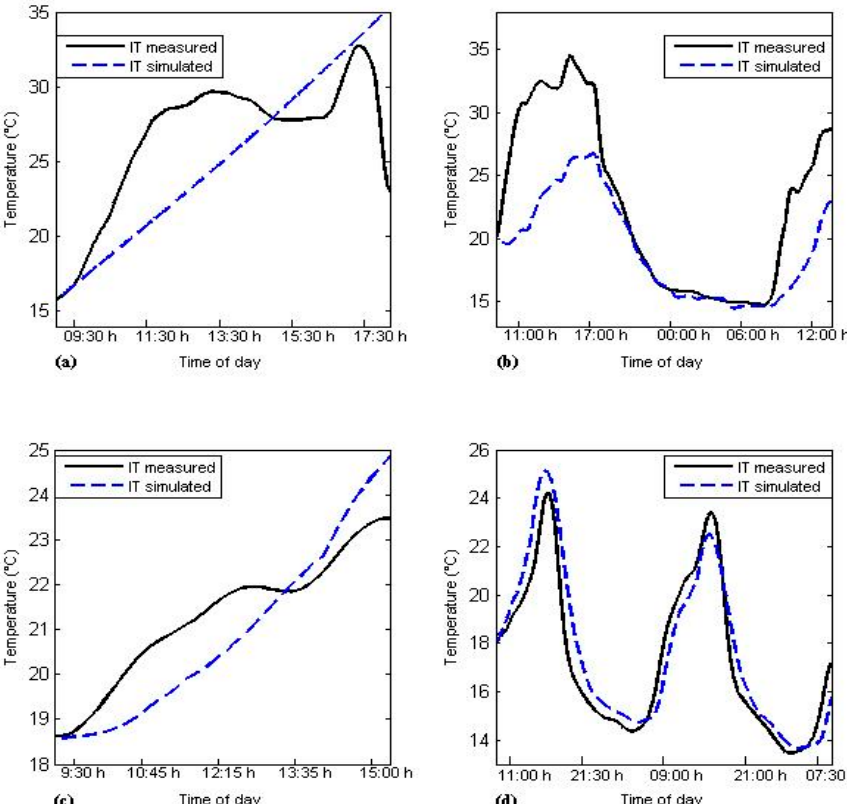
Figure A1. Model behavior in multiple scenarios. ( a ) The first scenario, where the growth chamber is empty. ( b ) The second scenario, where only is considered natural ventilation. ( c , d ) Third and fourth scenarios, when all variables in the simulation are included. Table A1. Comparison of simulated and measured values under different scenarios.